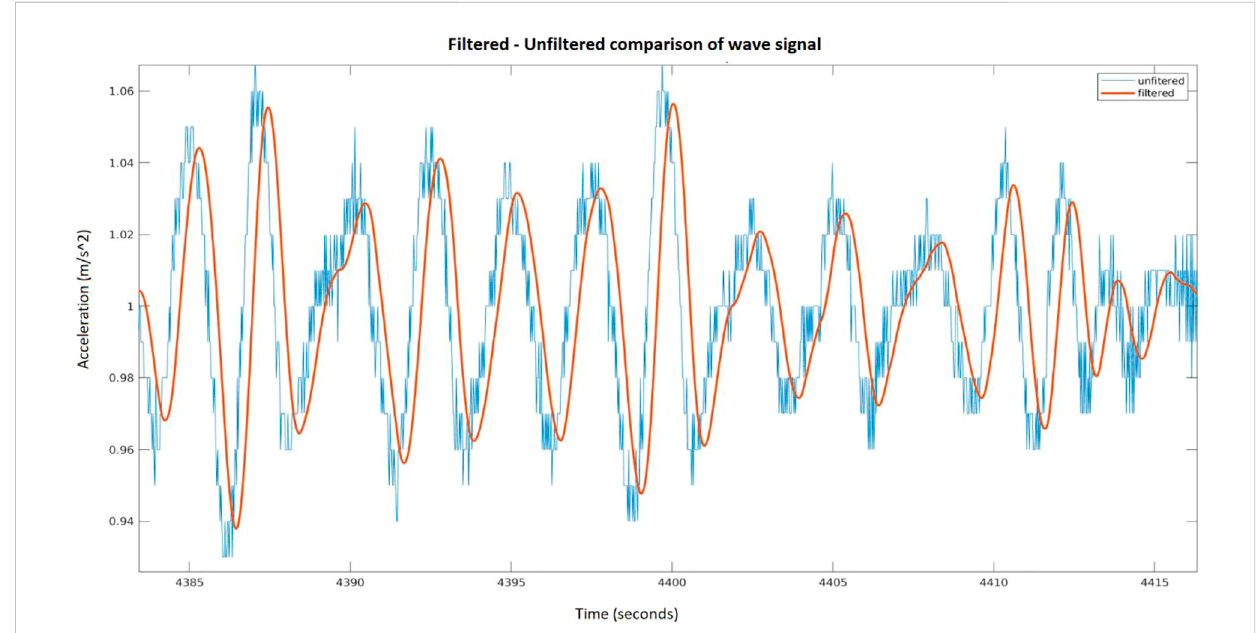
FIGURE 3 Denoising of the wave signal with a cut-off frequency of 1 Hz.